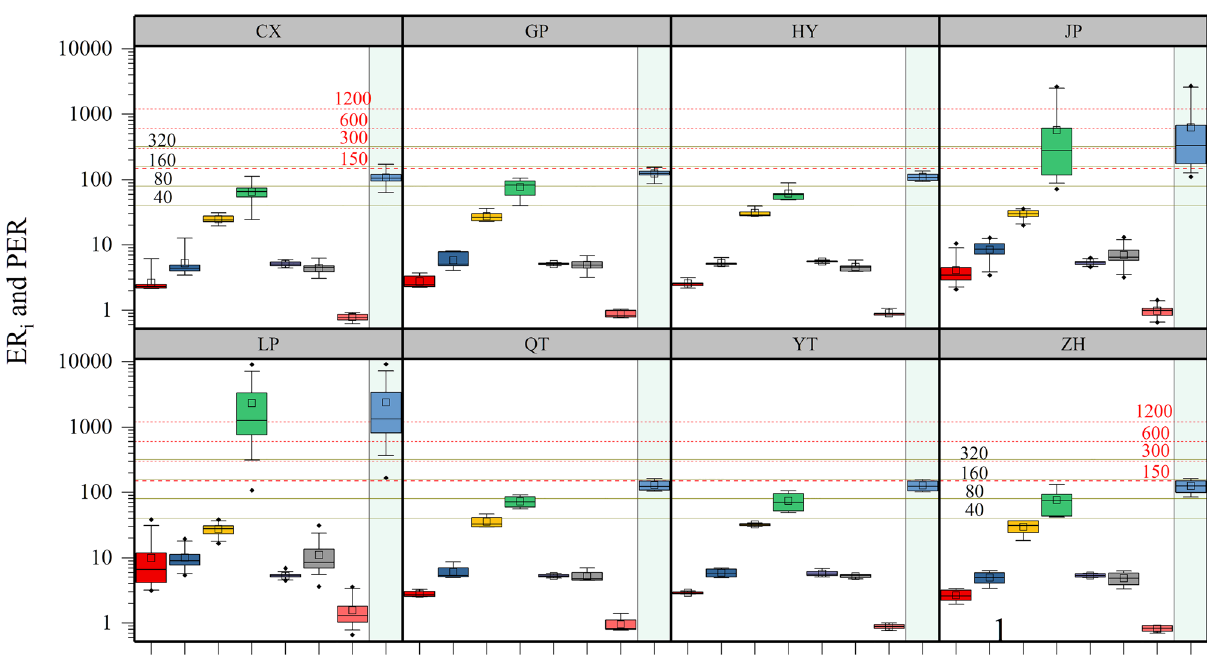
Figure 2. ER i and PER of HMs in various villages. Green horizontal reference lines represent the corresponding i classification criteria of E r (40, 80, 120, 320); Red horizontal reference lines represent the corresponding classification criteria of PER (150, 300, 600, 1200). Boxes represent the 25th and 75th percentiles, the whiskers represent the 5th and 95th percentiles, and the hollow squares represent